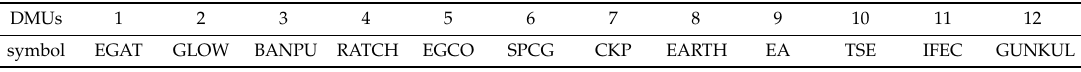
Table 2. Research